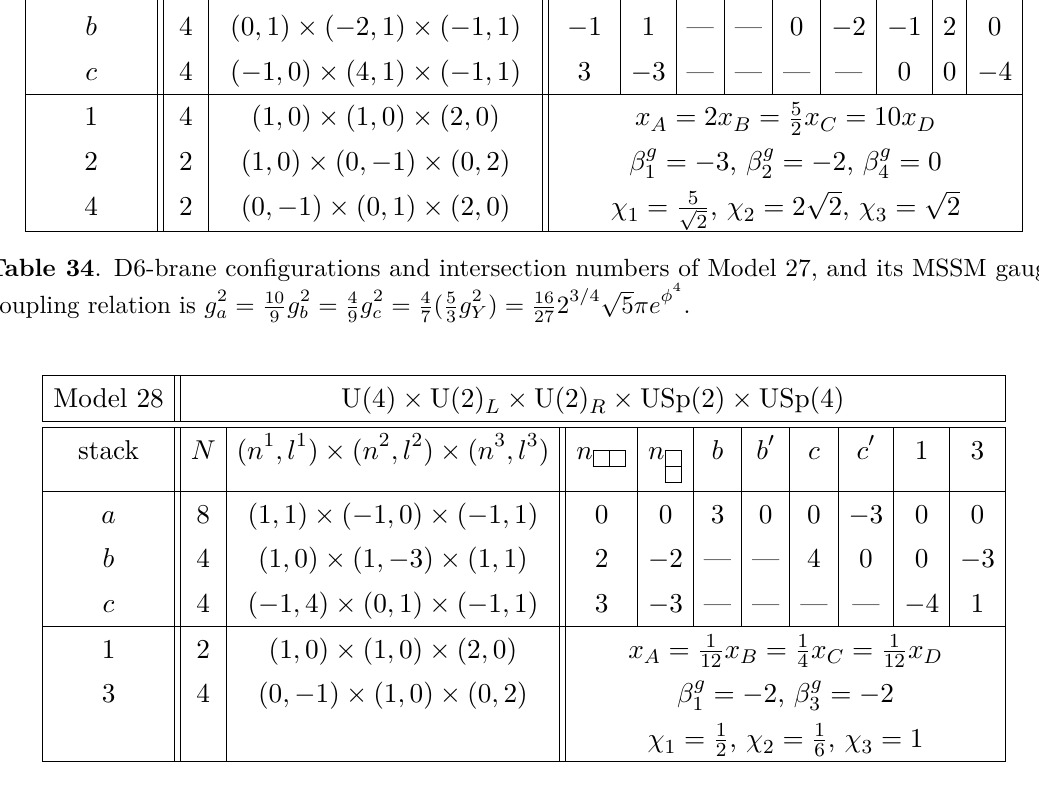
Table 35 . D6-brane configurations and intersection numbers of Model 28, and its MSSM gauge